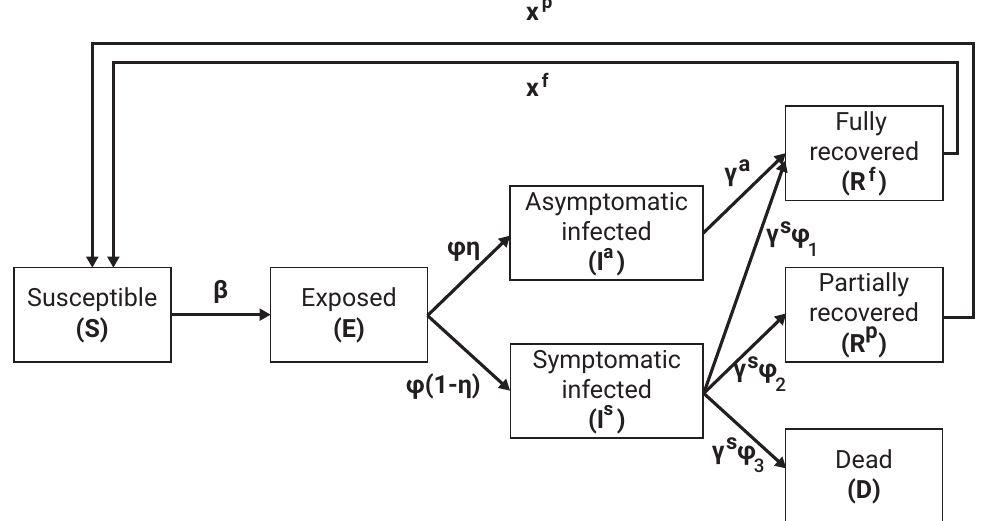
Figure 2. Schematic view of transition between epidemiological